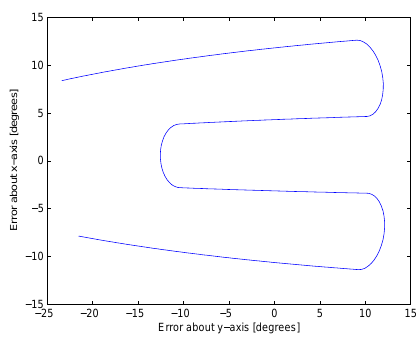
Figure 4: The orientation error by the method de- scribed in Section